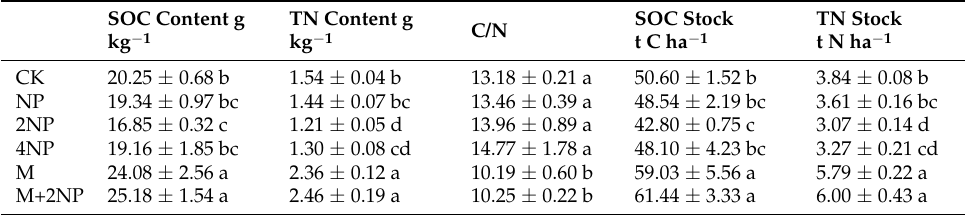
Table 4. Total SOC, TN content, and